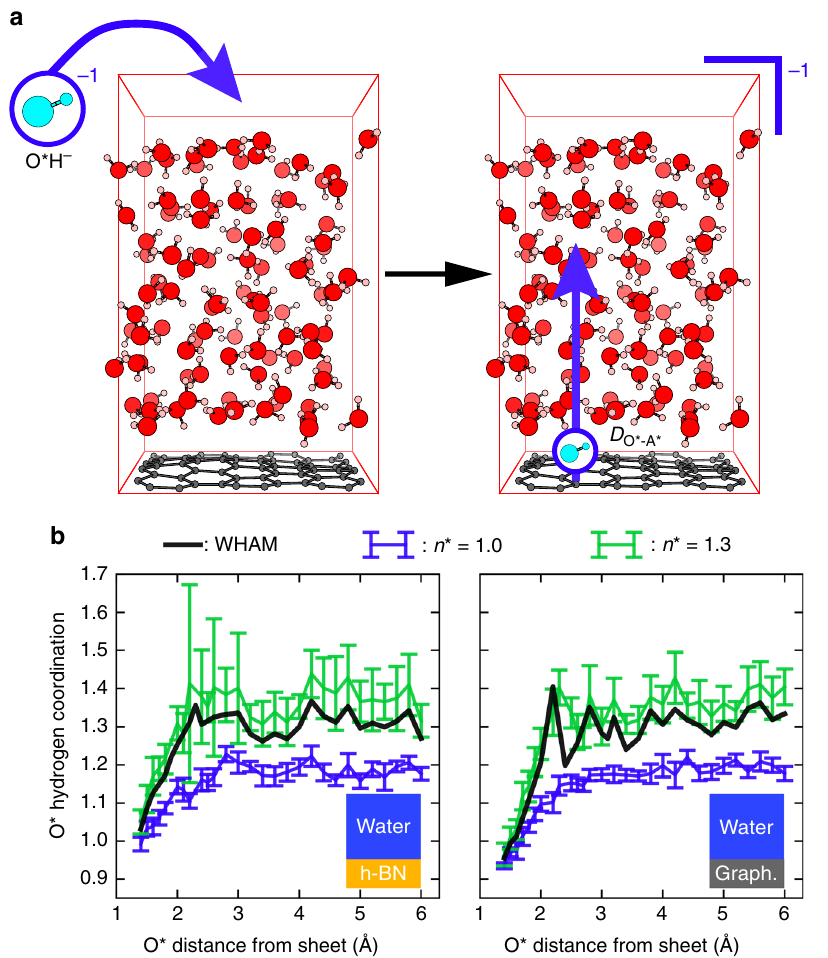
Fig. 1 Simulation cell and protocol. a Simulation cell: an anionic hydroxide is placed in a 12.83 Å × 12.35 Å × 21.0 Å orthorhombic cell containing a 60 atoms hexagonal graphene sheet in contact with a hundred water molecules (left) resulting in a charged cell (right) in which the hydroxide is progressively displaced (blue vertical arrow) from the surface to the bulk. The hydroxide, hydrogen, carbon and oxygen atoms are respectively represented in cyan, pink, grey and red. b Free energy or potential of mean force (PMF) simulation strategy for the water/h-BN and water/graphene interfaces in the constraint ’ s landscape. For each fi xed distance of the hydroxide oxygen O * from the sheets, two MD runs are performed while restraining the hydrogen coordination of O * by a harmonic potential with a target of respectively n * = 1.0 (blue curve) and n * = 1.3 (green curve). The two sets of MD simulations thus obtained are represented by the mean hydrogen coordination and fl uctuations around the mean (standard deviations as error bars). They are later combined into a third trajectory labelled WHAM (black curve) using the Weighted Histograms Analysis Method (WHAM) at each ion-surface distance